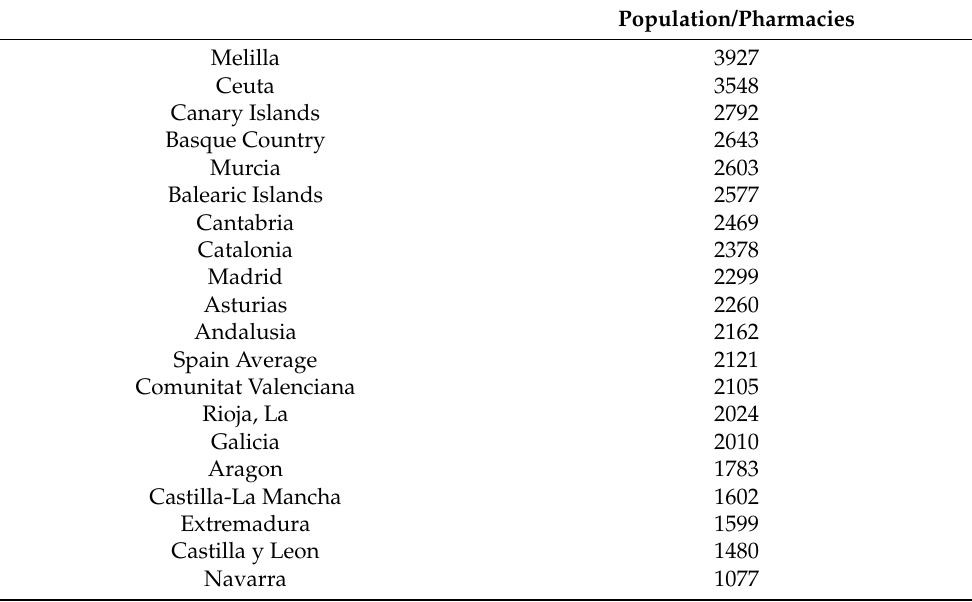
Population/Pharmacies